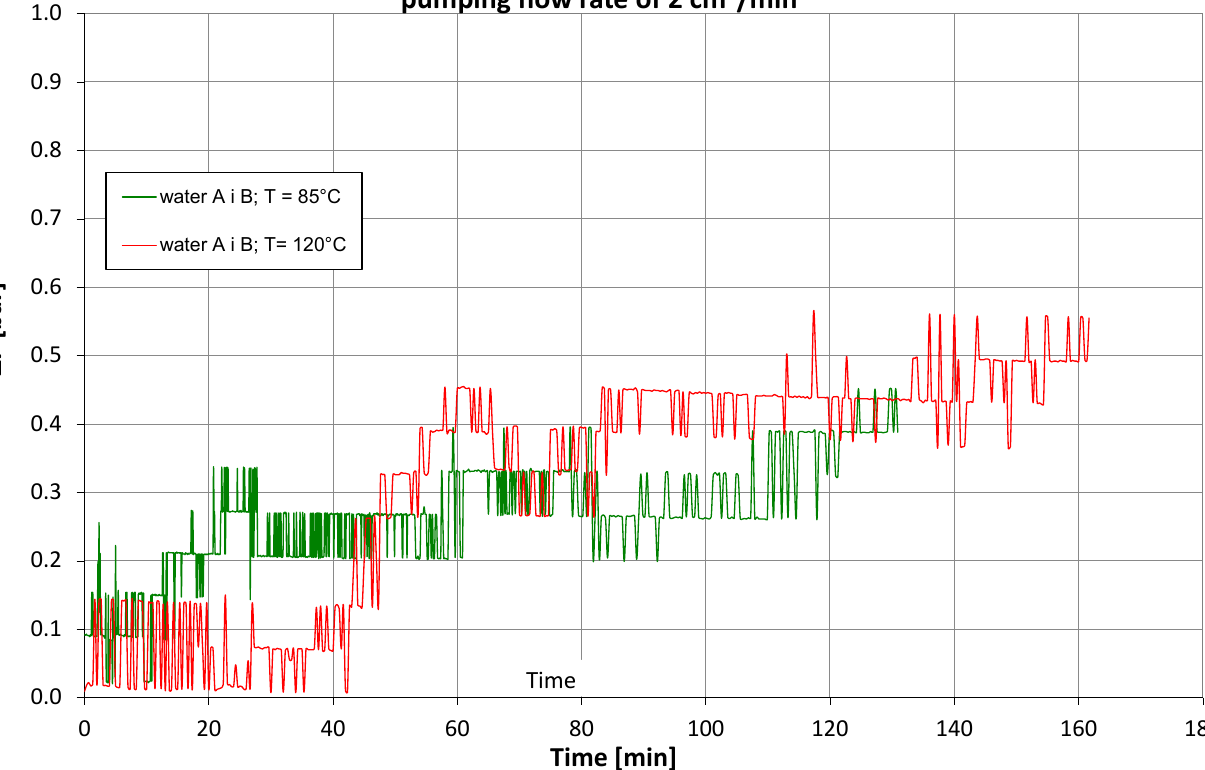
Figure 3. The course of the study of individual geothermal water types (measurement error is ±4%).